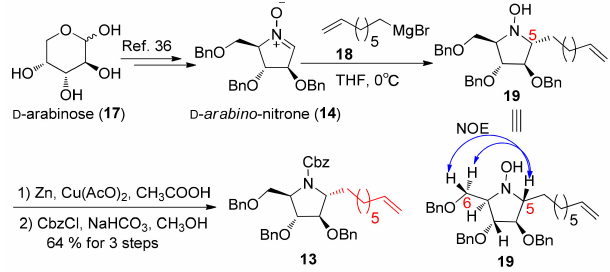
Scheme 2. Synthesis of the pyrrolidine core